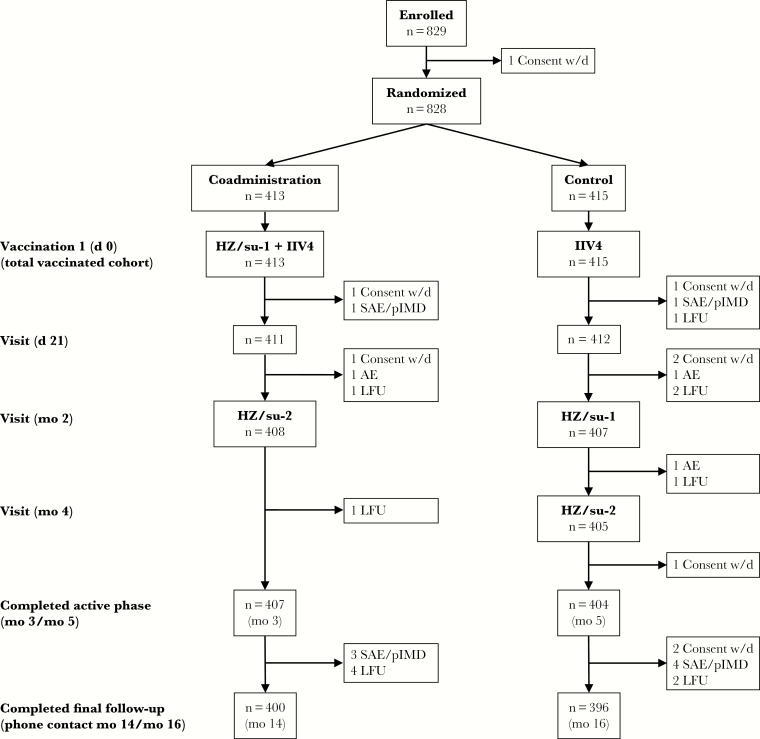
Subject disposition. A total of 828 subjects aged ≥50 years were randomized to the 2 treatment groups. Subjects in the coadministration group received the first herpes zoster subunit (HZ/su) vaccination (HZ/su-1) and the quadrivalent seasonal inactivated influenza vaccine (IIV4) vaccination in different arms on day 0 (d 0) and the second HZ/su vaccination (HZ/su-2) at month 2 (mo 2). Subjects in the control group received the IIV4 vaccination on day 0, HZ/su-1 at month 2, and HZ/su-2 at month 4. Blood samples for immunogenicity analyses were collected on day 0, day 21, and month 3 for the coadministration group, and on day 0, day 21, month 2, and month 5 for the control group. The final study follow-up was a phone call to collect final safety data 1 year after the HZ/su-2 vaccination. Subjects were withdrawn from the study owing to a serious adverse event (SAE) or potential immune-mediated disease (pIMD) (9 subjects), a nonserious adverse event (AE; 3 subjects), withdrawn consent (w/d; 8 subjects), or loss to follow-up (LFU; 12 subjects).